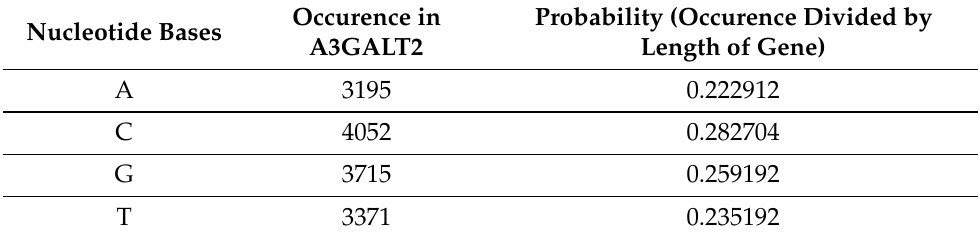
Table 1 (a: 0.222912, c: 0.282704, g: 0.259192, t: 0.235192) we see that they are correct up to the fourth decimal place. Table 1. Occurence of nucleotide bases in A3GALT2. Nucleotide Bases